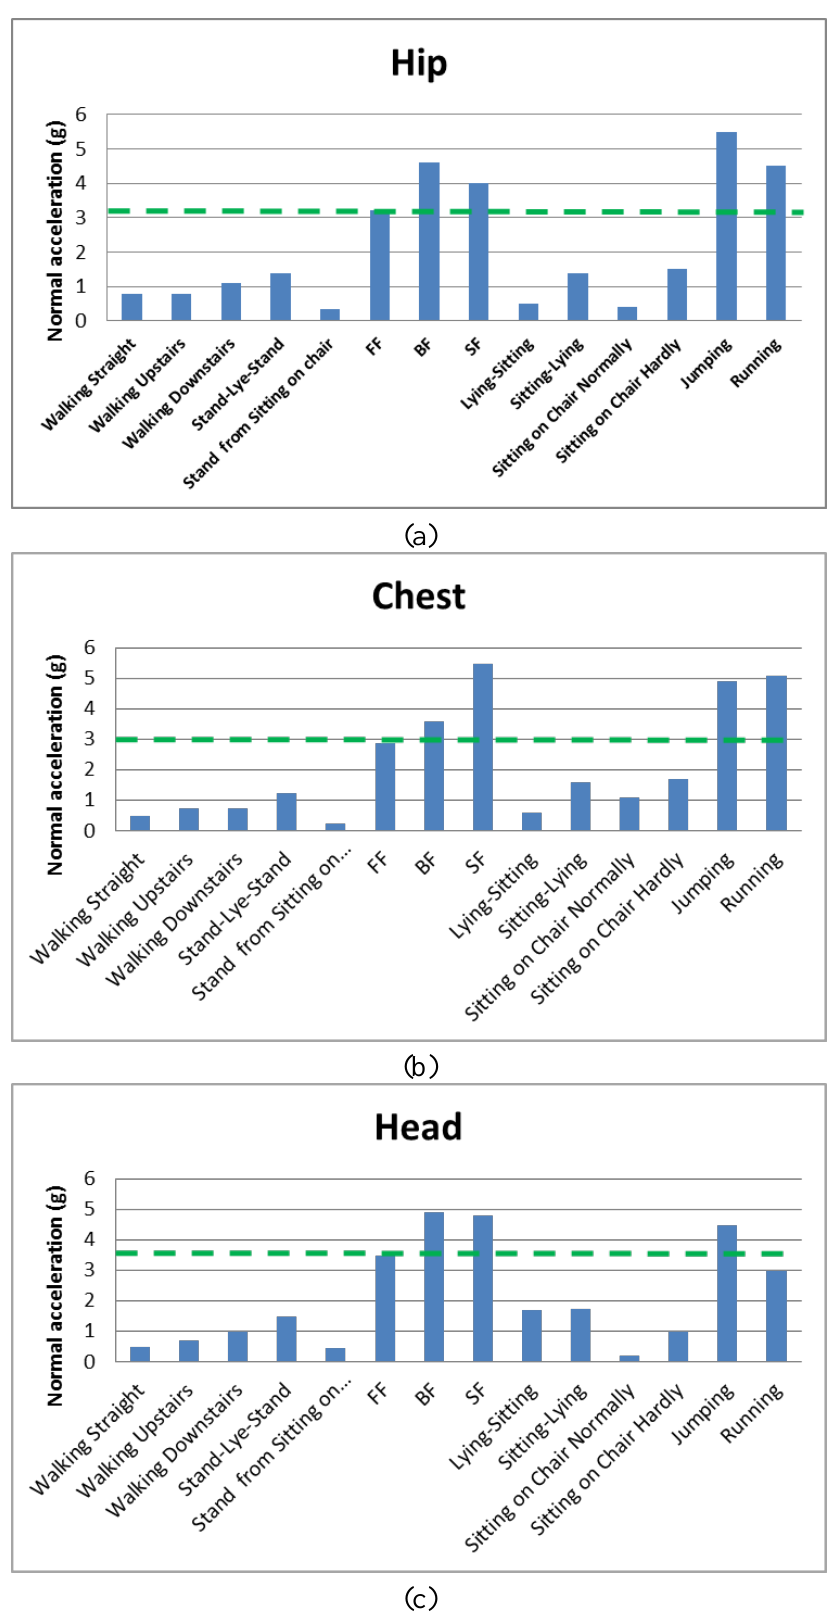
Figure 7. Measured normal acceleration of ADL and different kinds of falls: ( a ) hip; ( b ) chest; ( c )